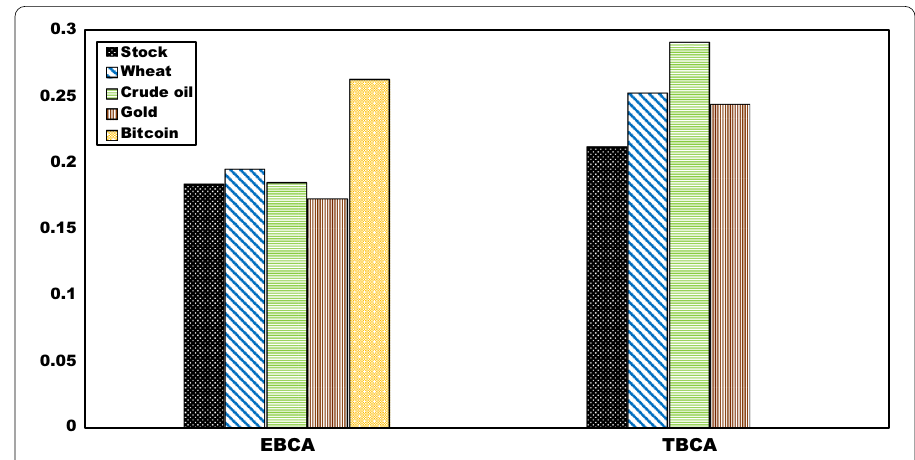
Fig. 8 Overall portfolio distribution of the EBCA and TBCA